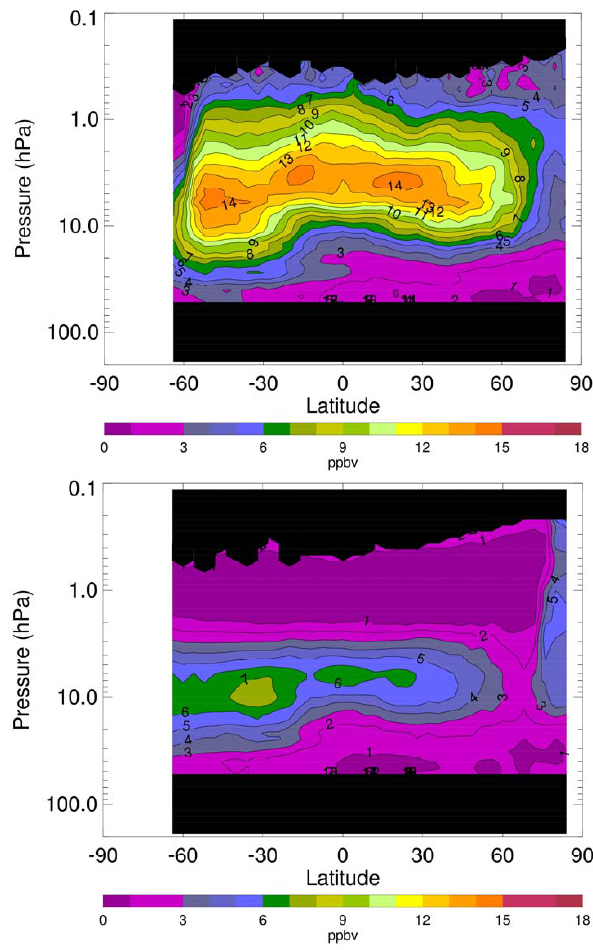
Fig. 2. LIMS V6 distributions for 15 November 1978 of (top) de- scending (or nighttime) NO 2 and of (bottom) ascending (or day- time) NO 2 both in ppbv. Orange colors are high values, while magenta-to-purple colors are low values; blackened regions indi- cate where there are no data. There is a crossover to polar night conditions at about 75 ◦ N for the ascending NO 2